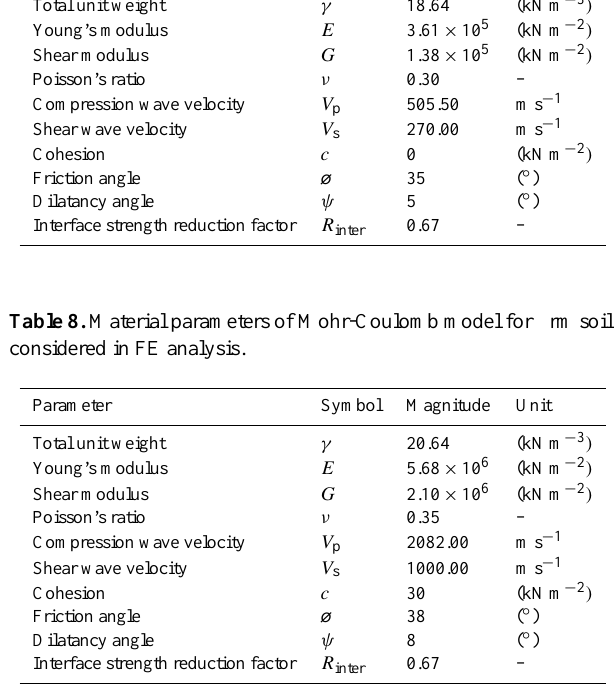
Table 7. Material parameters of Mohr-Coulomb model for medium firm soil considered in FE analysis.